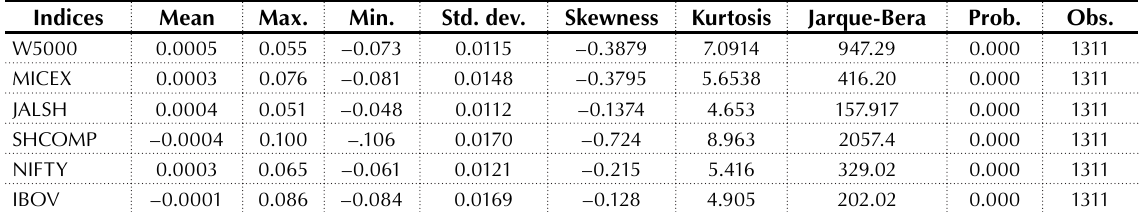
Table 1. Basic statistical properties of US and BRICS stock market indices,